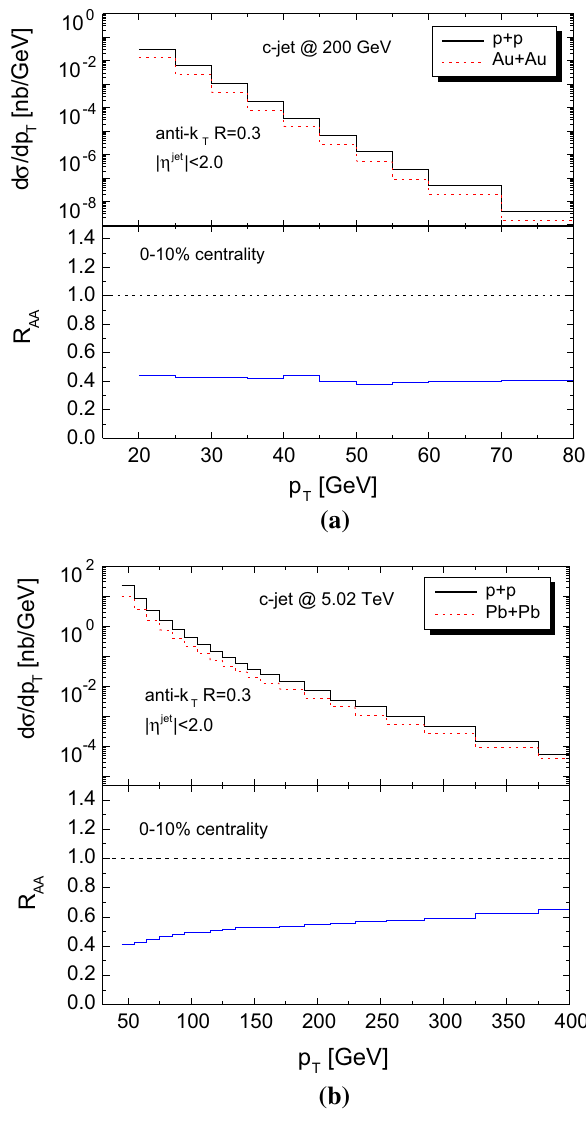
Fig. 8 a The c-jet cross section versus transverse momentum in a p + p and 0 − 10% Au + Au collisions at 200 GeV, b p + p and 0 − 10% Pb + Pb collisions at 5.02 TeV, as well as the nuclear modification factor R AA ( p T ) . The charm jets are reconstructed with cone size R = 0 . 3 and | η jet | < 2 . 0.